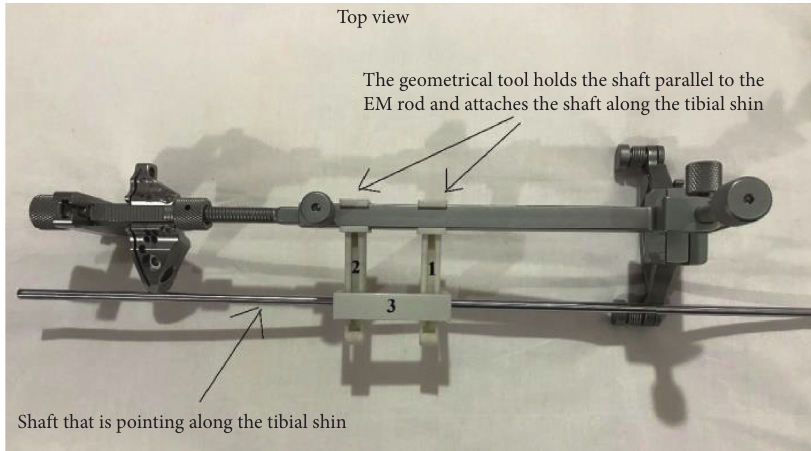
Figure 6: The EM guide with the left cutting block and the geometrical tool prepared to be used for left knees.